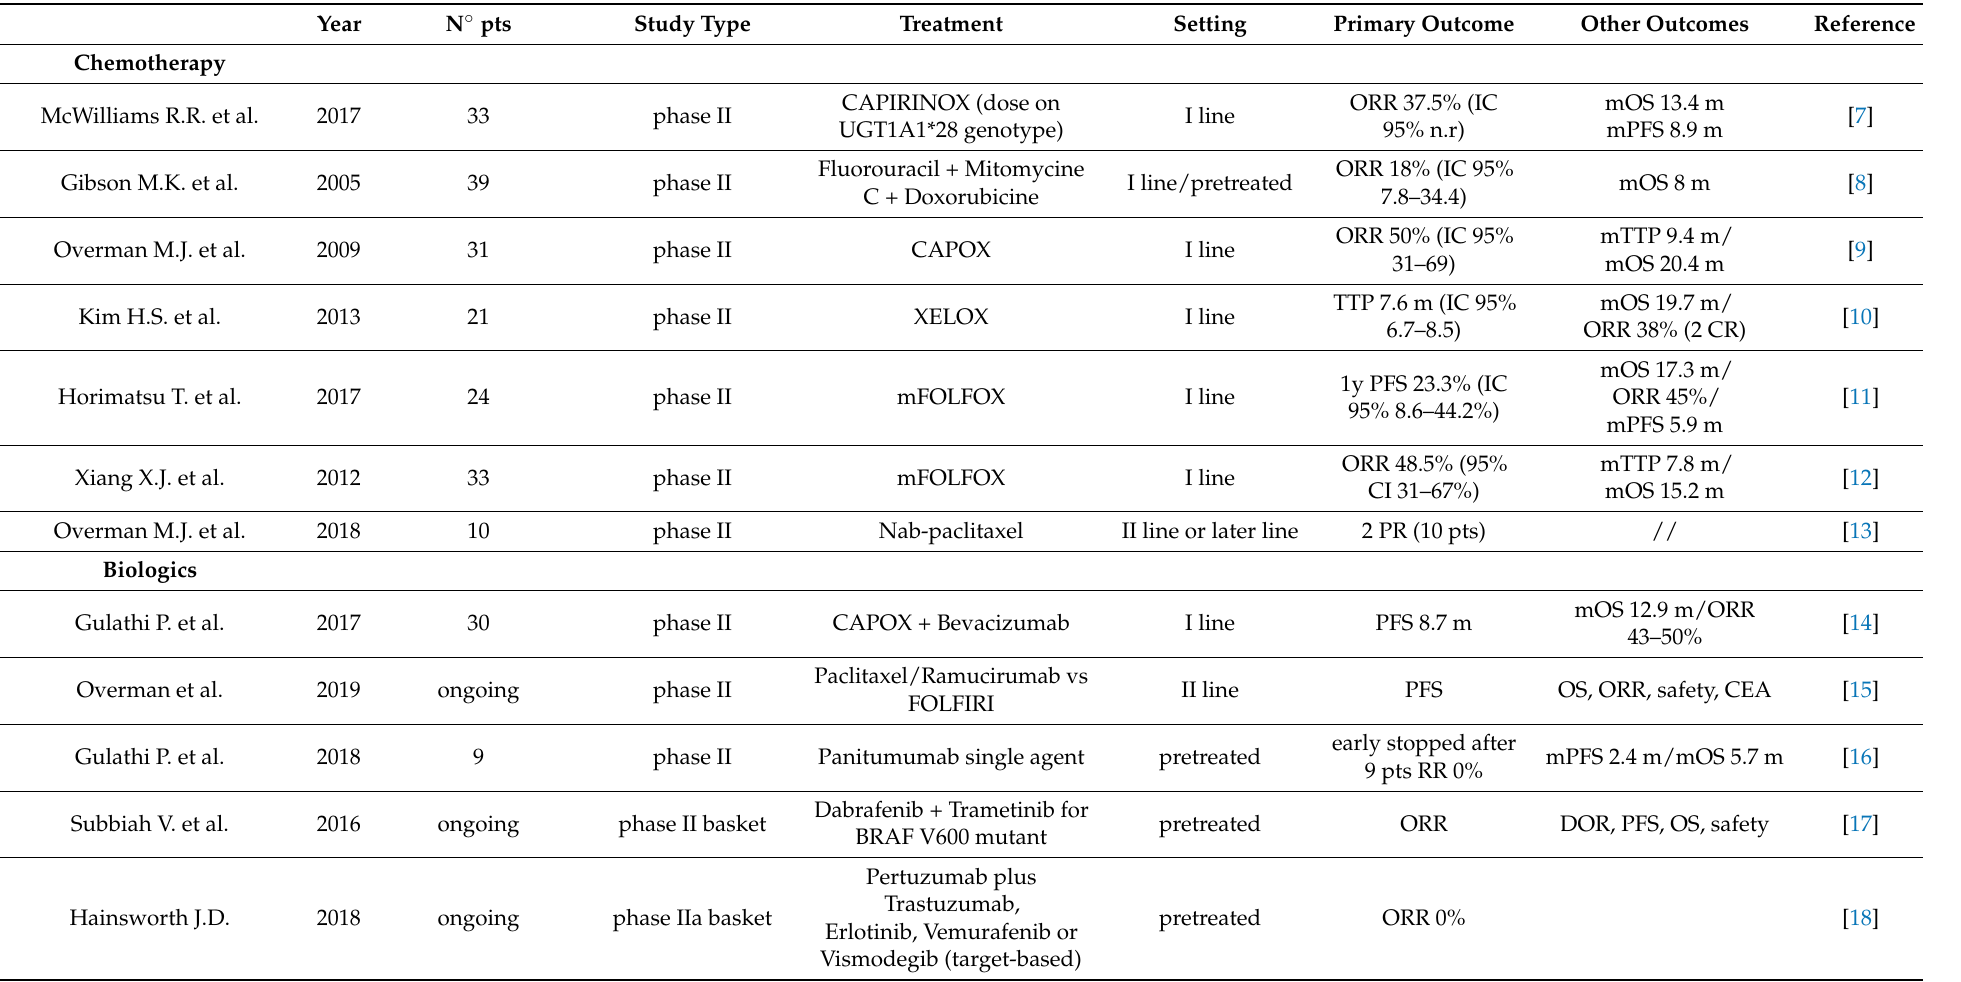
Table 1. Studies regarding systemic treatments in advanced small bowel